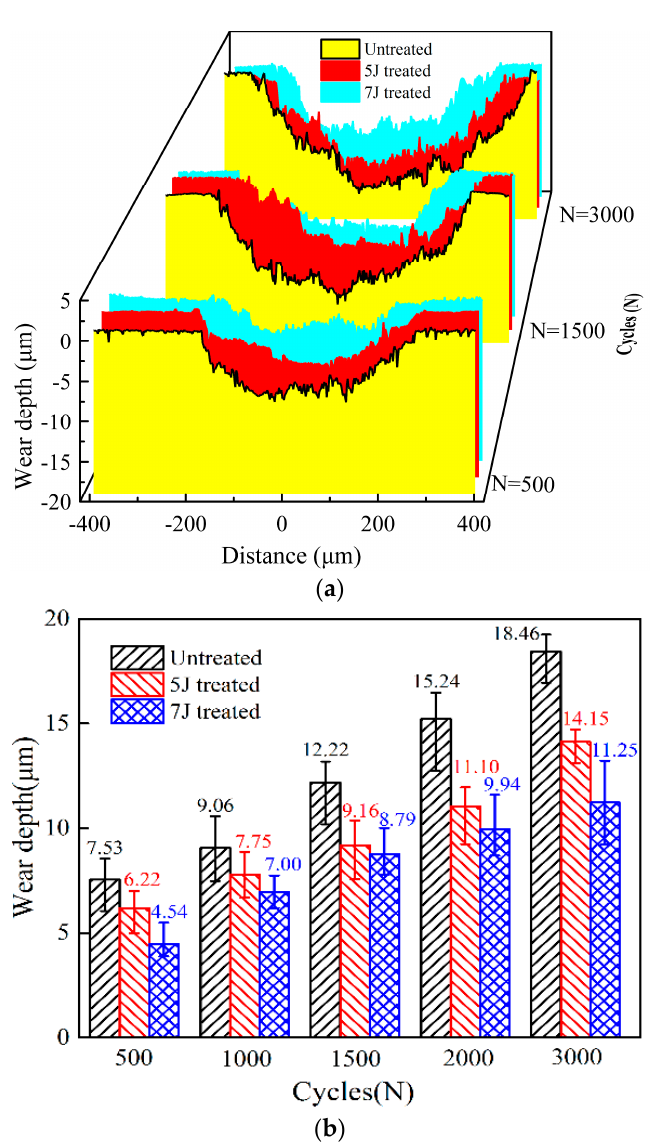
Figure 11. Profile of wear scars under various number of cycles. ( a ) 2-D Profile of wear scars; (b ) Maximum wear depth.